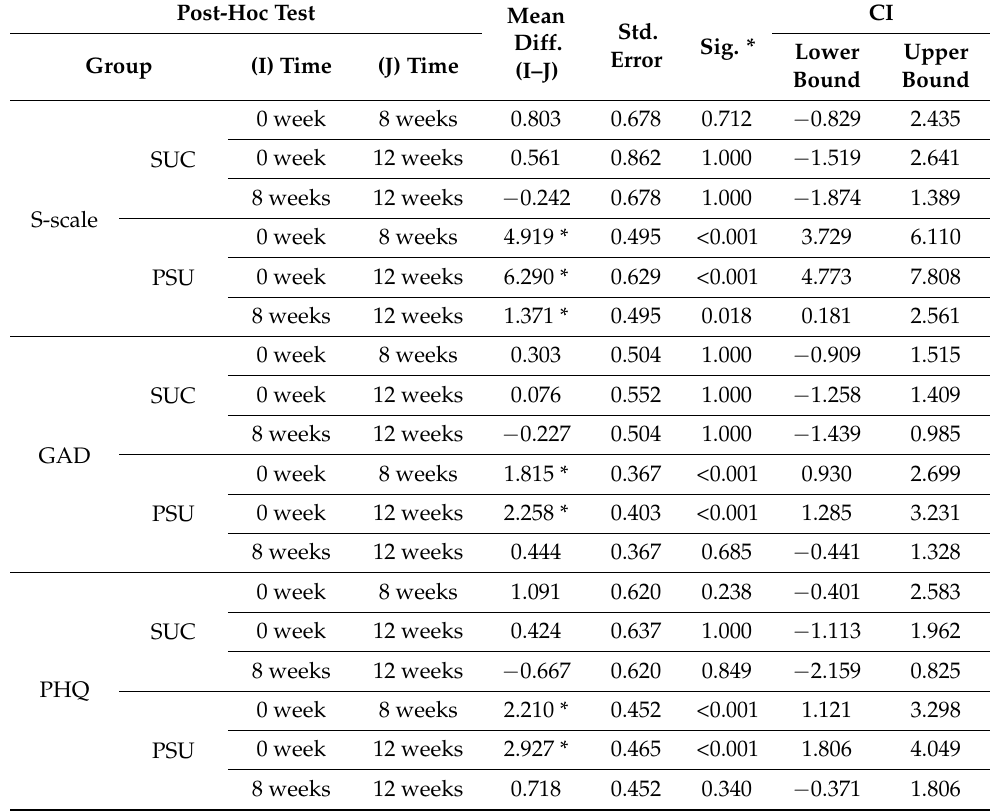
Table 2. Results of post hoc analysis (S-scale, GAD, PHQ).